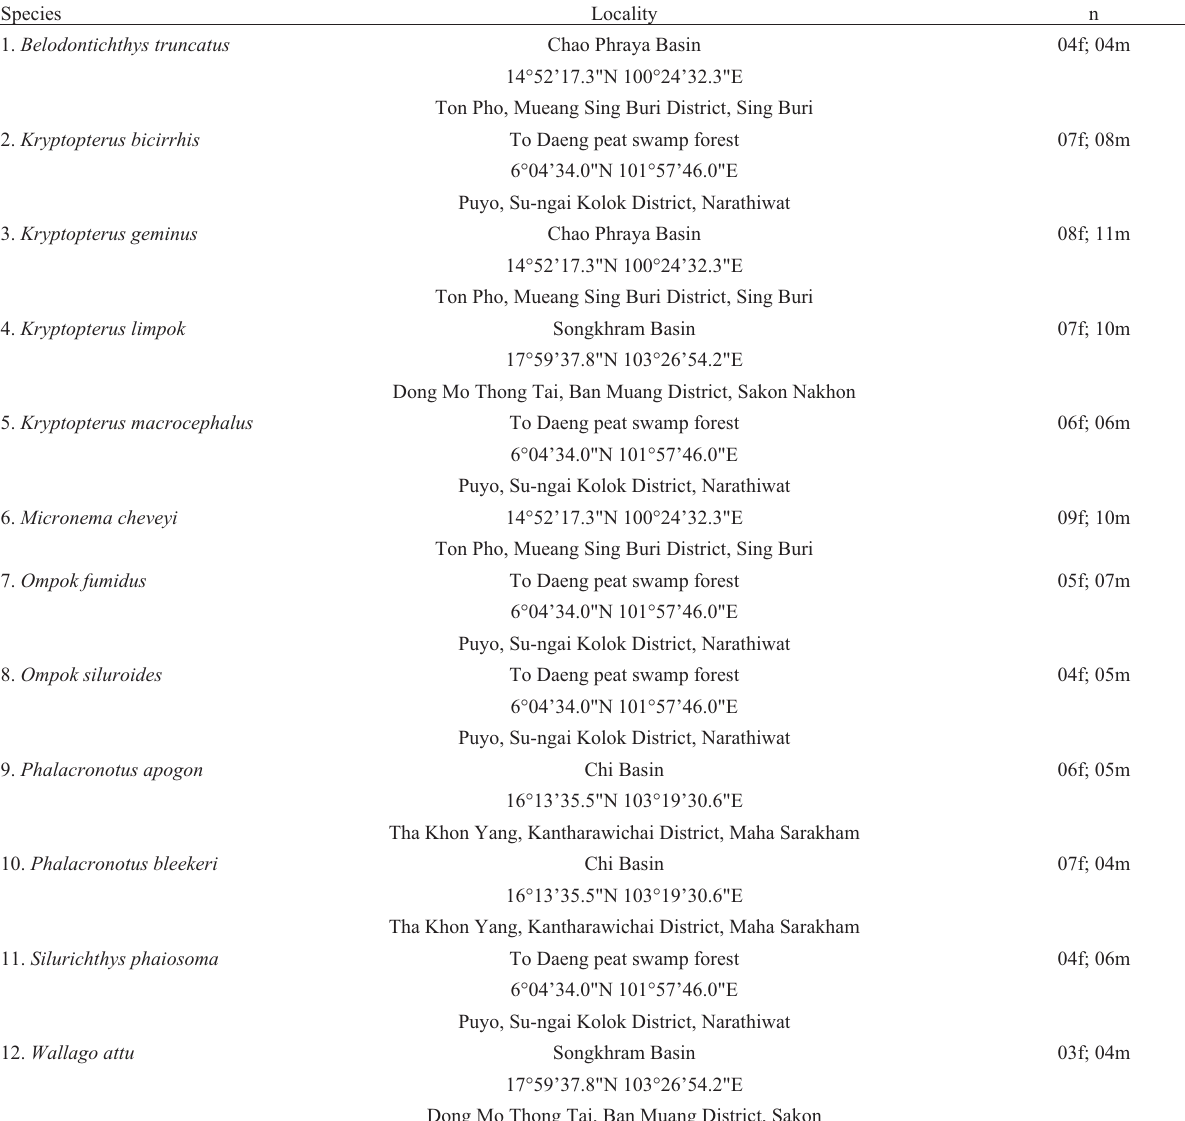
Table 1 - Species analyzed, collection sites and the number of analyzed individuals (n). Species Locality